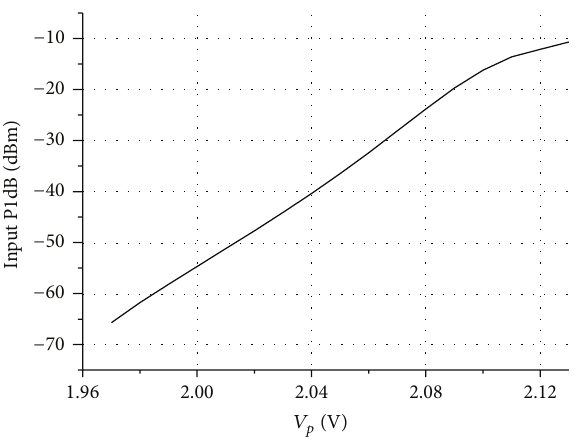
Figure 12: Voltage gain and gain linearity versus control voltage 𝑉 𝑝 .